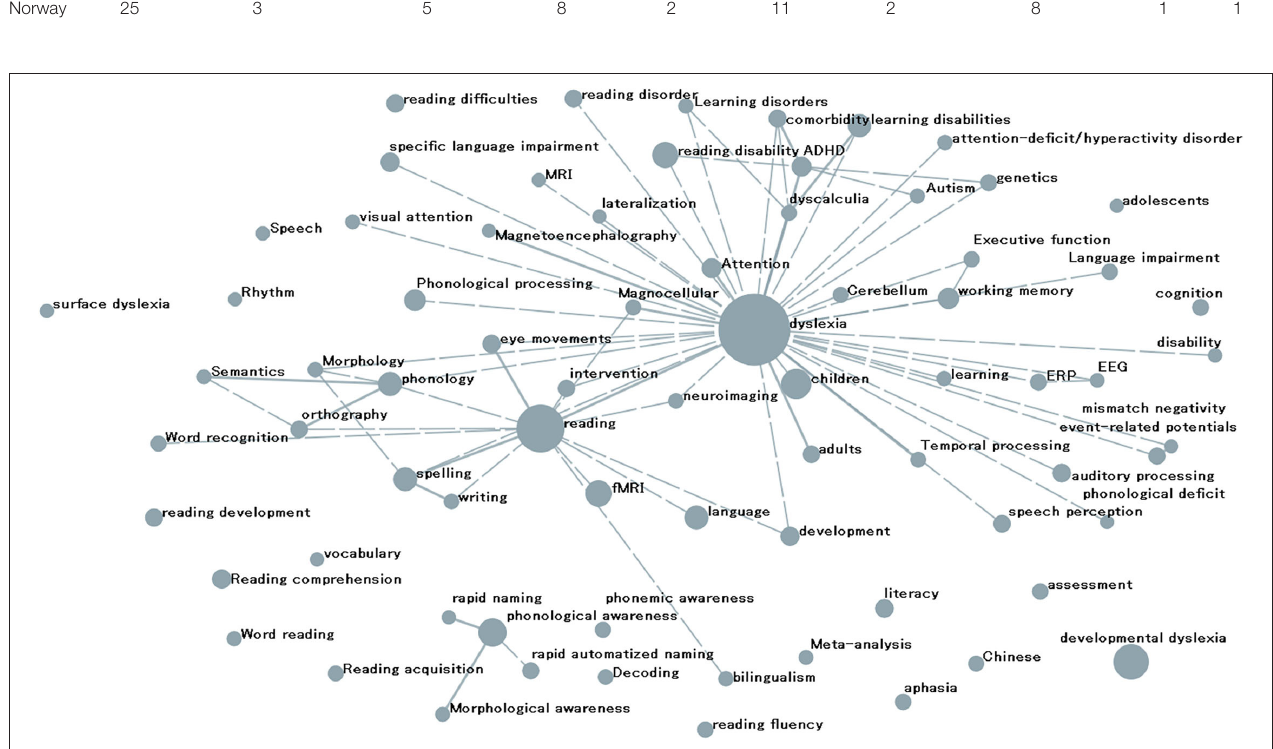
FIGURE 5 | Globe research hot points related to